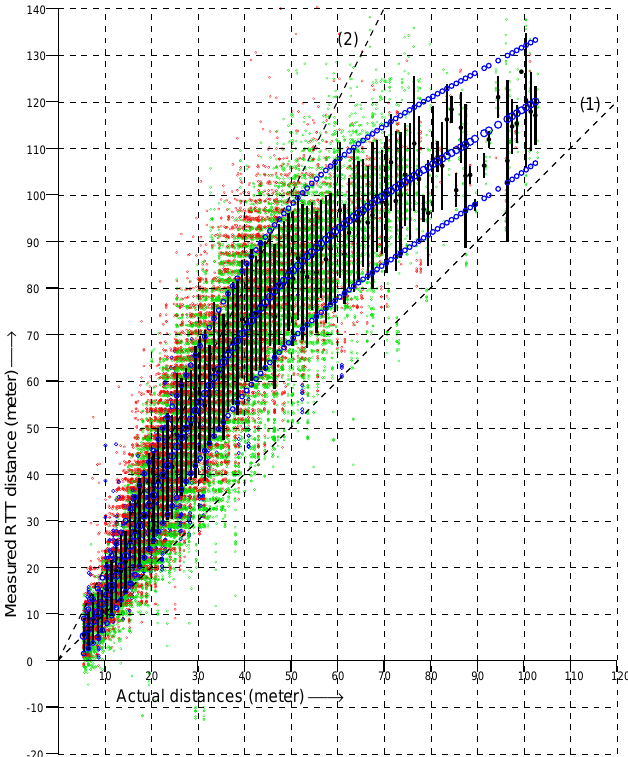
Figure 5. Scattergram with curve fit superimposed. Dashed lines indicate slope (1) and (2). Each vertical black bar is a line from µ − σ to µ + σ where µ and σ are the average and standard deviations of the RTT response for that actual distance. The corresponding values for a curve fit are shown as small blue circles.